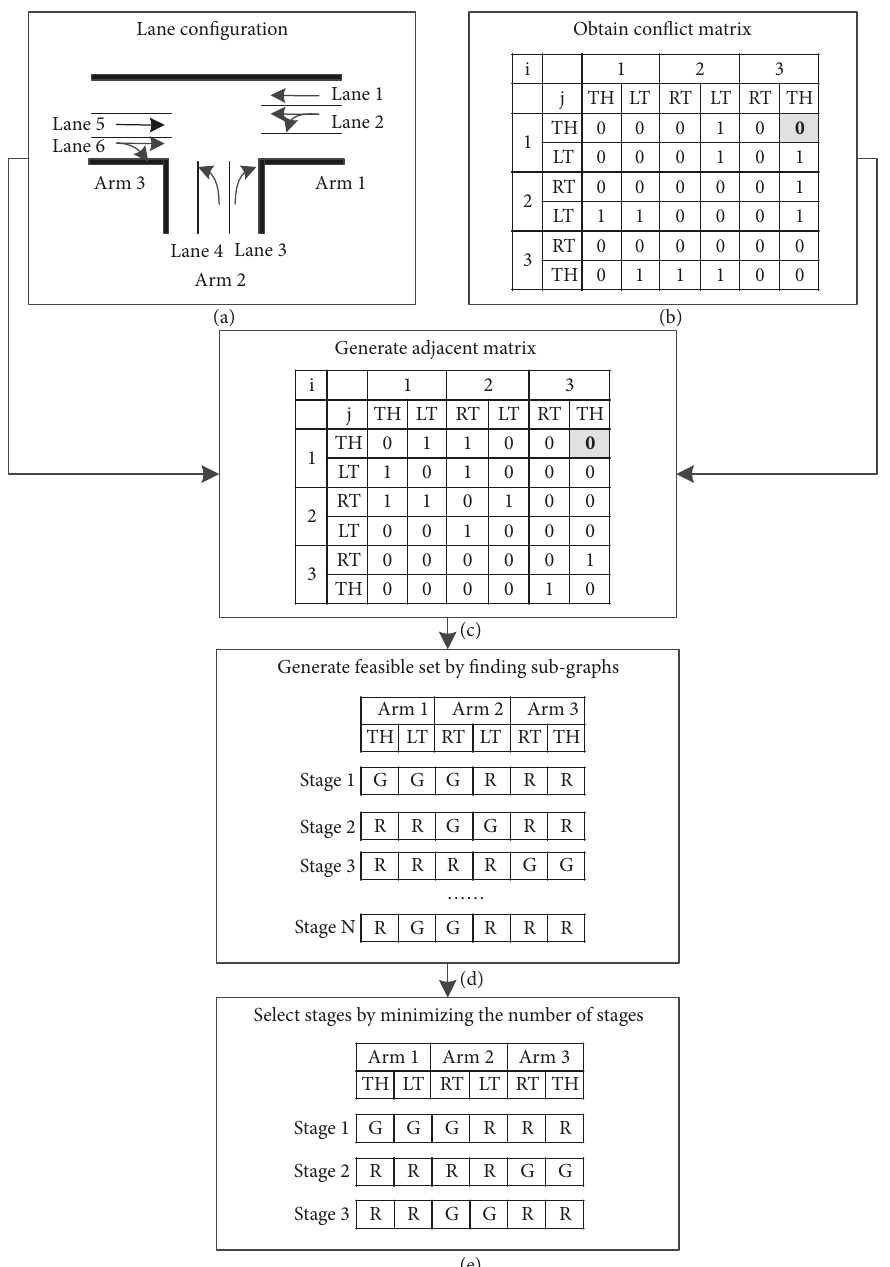
Figure 3: An example of stage generation: (a) lane configuration; (b) obtaining conflict matrix; (c) generation of adjacent matrix; (d) generation of feasible set by finding subgraphs; (e) selecting stages by minimizing the number of stages.